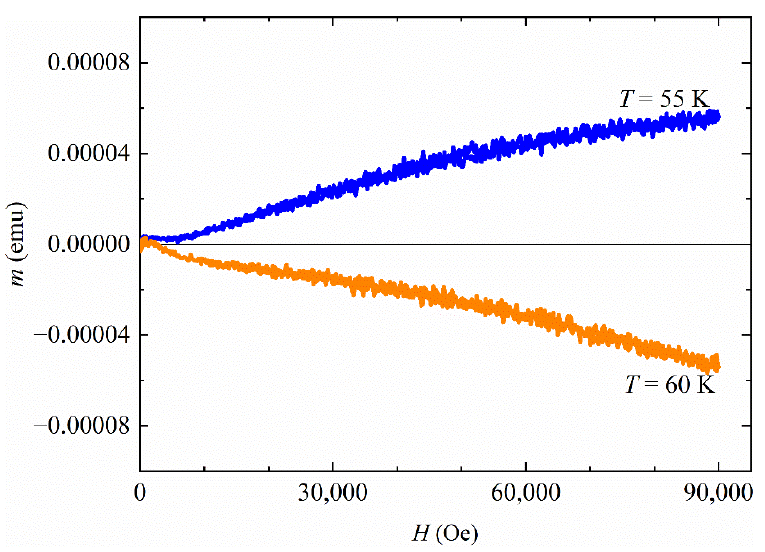
Figure 2. m ( H ) curves at T = 55 K and T = 60 K.